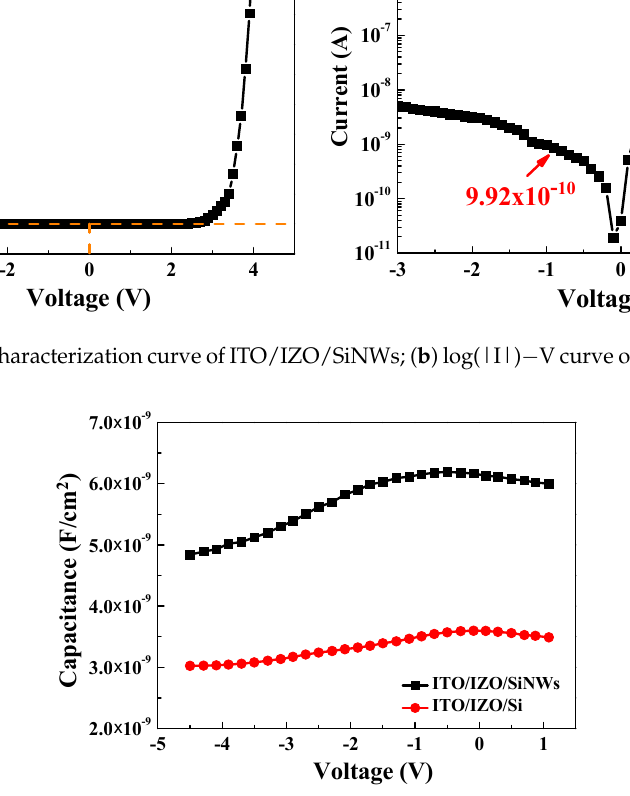
Figure 10. C–V measurement of the ITO/IZO/Si and ITO/IZO/SiNW heterojunction diode.